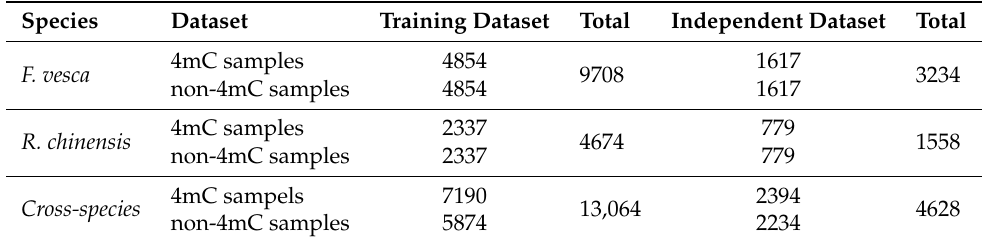
Table 1. Benchmark datasets